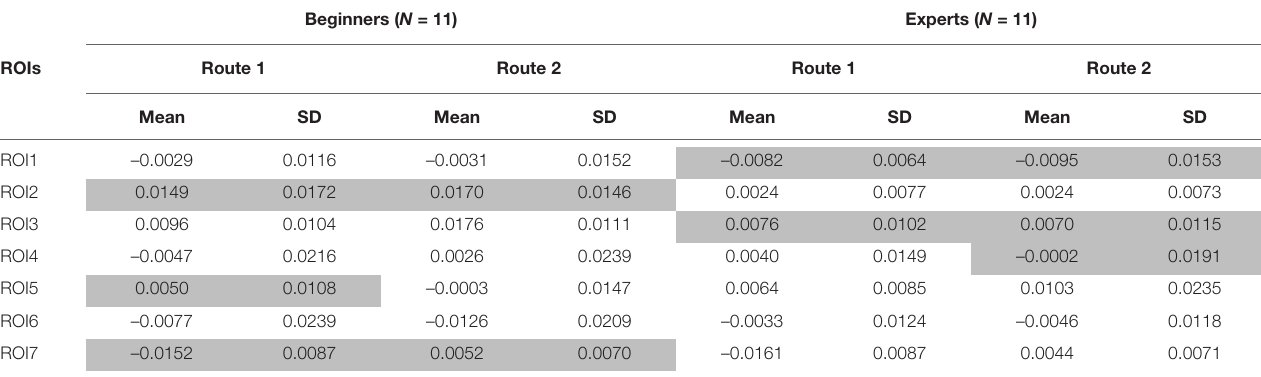
TABLE 1 | Descriptive statistics: means and standard deviations of [Oxy-Hb] concentration changes for both groups (Beginners and Experts), both Routes (1: easy and 2: difficult) for each ROI (ROI1-ROI7) are illustrated. Beginners ( N =